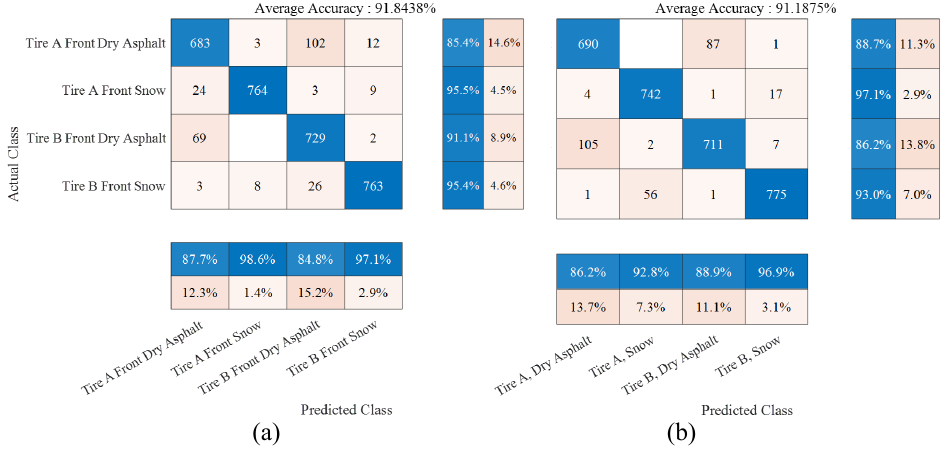
Figure 13. Test results for TPIN signals using CNN architecture for classification of road surfaces and tires: ( a ) front-wheel data; ( b ) rear-wheel data.